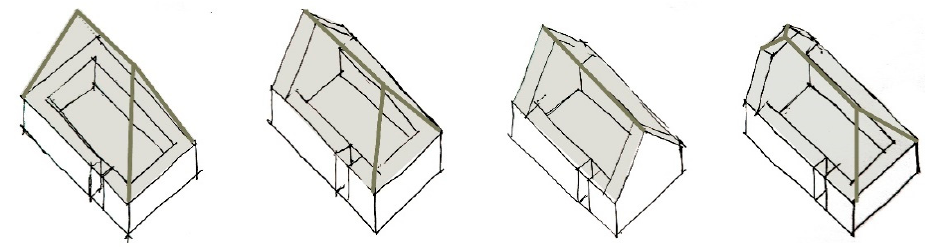
Figure 13. Variants of gladas’ walls: a leveled sidewall, one gable wall, two gable walls and a half-gable wall drawing: A. Kapetanovi ć .